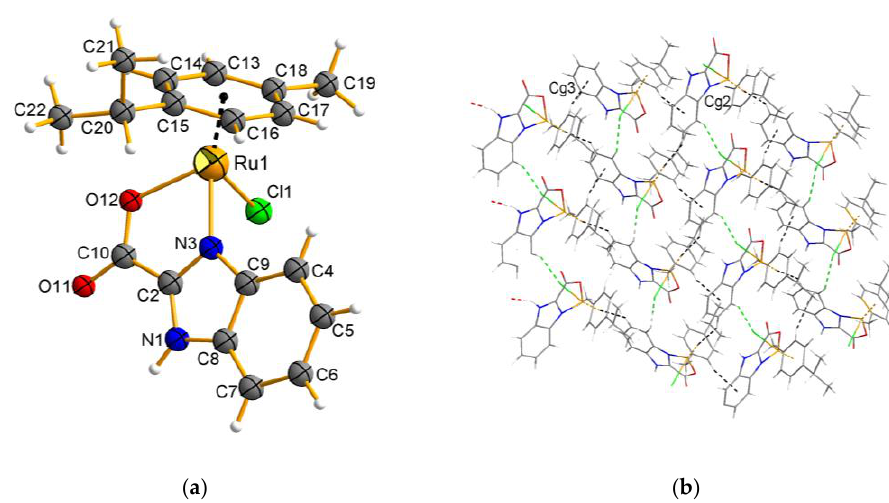
Figure 1. Molecular structure of complex 1 ( a ). Crystal packing with marked supramolecular interactions of C–H ··· Cl and C–H ··· π types forming zig-zag chains (view along z-axis ) ( b ).